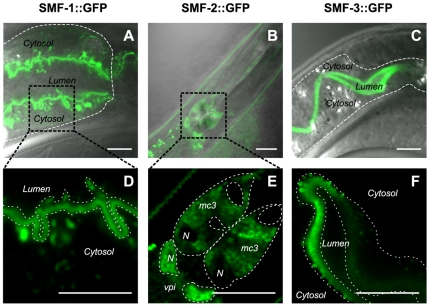
Subcellular localization of SMF::GFP reporters.SMF-1::GFP mostly localizes to the apical plasma membrane of the intestine and sub-apical compartments (A, D, dotted line in A underlines the basolateral membrane of the intestine, dotted lines in D delimit its apical plasma membrane). SMF-2::GFP is seen in cytoplasmic organelles in mc and vpi cells (E, cell plasma membranes are marked by a dotted line, N indicate the position of the nuclei). SMF-3::GFP is mainly restricted to the apical plasma membrane of the intestine and apical vesicular organelles (C, F, dotted line in C underlines the basolateral membrane of the intestine, dotted lines in D delimit its apical plasma membrane). Scale bars are 5 µm.